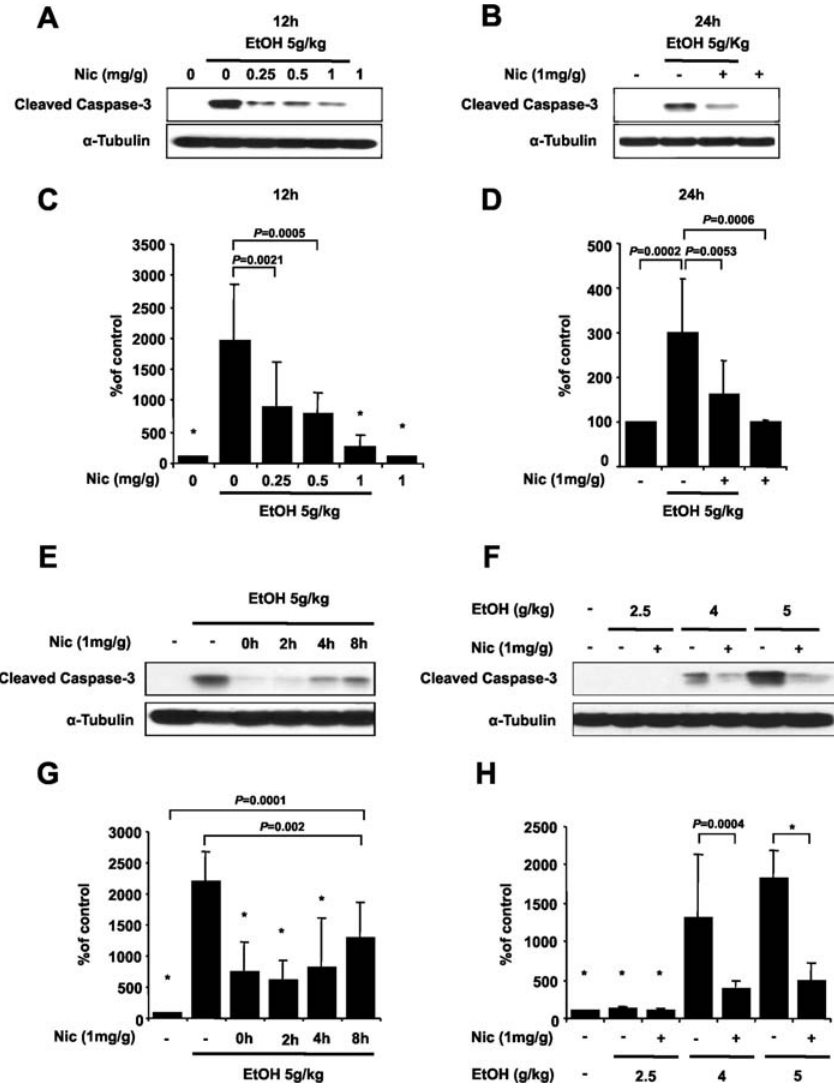
Figure 1. Nicotinamide Inhibits Ethanol-Induced Caspase-3 Activation (A–D) P7 mice were injected with ethanol and received nicotinamide 2 h later. (A and B) Level of cleaved caspase-3 was analyzed by Western blot at 12 h (A) and 24 h (B) after ethanol administration with different doses of nicotinamide. (C and D) Densitometric quantification of cleaved caspase-3 at 12 h (ANOVA F 5,27 ¼ 10.989; p , 0.0001; n ¼ 5–6 each treatment group) (C) and 24 h (ANOVA F 3,18 ¼ 8.851; p ¼ 0.0008; n ¼ 6 each treatment group) (D). (E and G) Nicotinamide was administered to P7 mice at different time points after ethanol exposure. Western blot analysis of caspase-3 activation 12 h after ethanol injection (E) and densitometric quantification (ANOVA F 5,33 ¼ 15.061; p , 0.0001; n ¼ 6–7 each treatment group) (G). (F and H) Different doses of ethanol were administered to P7 mice and nicotinamide was injected 2 h later. Western blot analysis of caspase-3 activation 12 h after ethanol injection (F) and densitometric quantification (ANOVA F 6,28 ¼ 18.183; p , 0.0001; n ¼ 5 each treatment group) (H). Values are shown as mean 6 SD. Bonferroni correction for multiple comparisons revealed a significant difference between the ethanol treatment group and all other groups. (cid:2) p , 0.0001. DOI: 10.1371/journal.pmed.0030101.g001